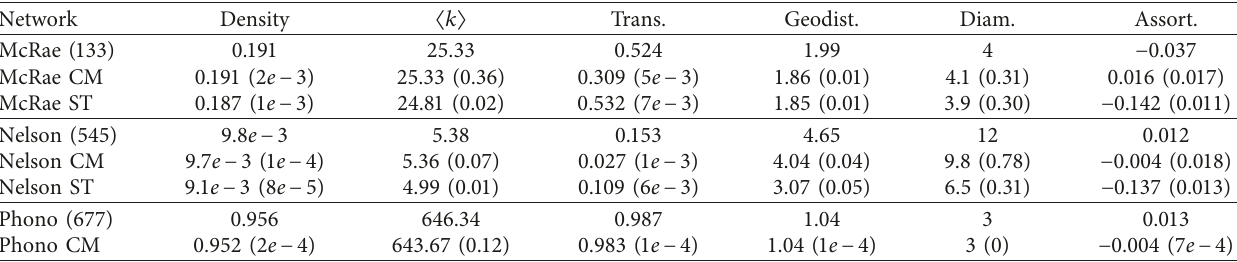
Table 1: Network summary statistics of network size (included next to the observed network name and consistent across all random models), network density, mean degree ( 〈 k 〉 ), measure of transitivity (trans.), mean geodesic distance (geodist.), diameter (diam.), and assortativity coefficients